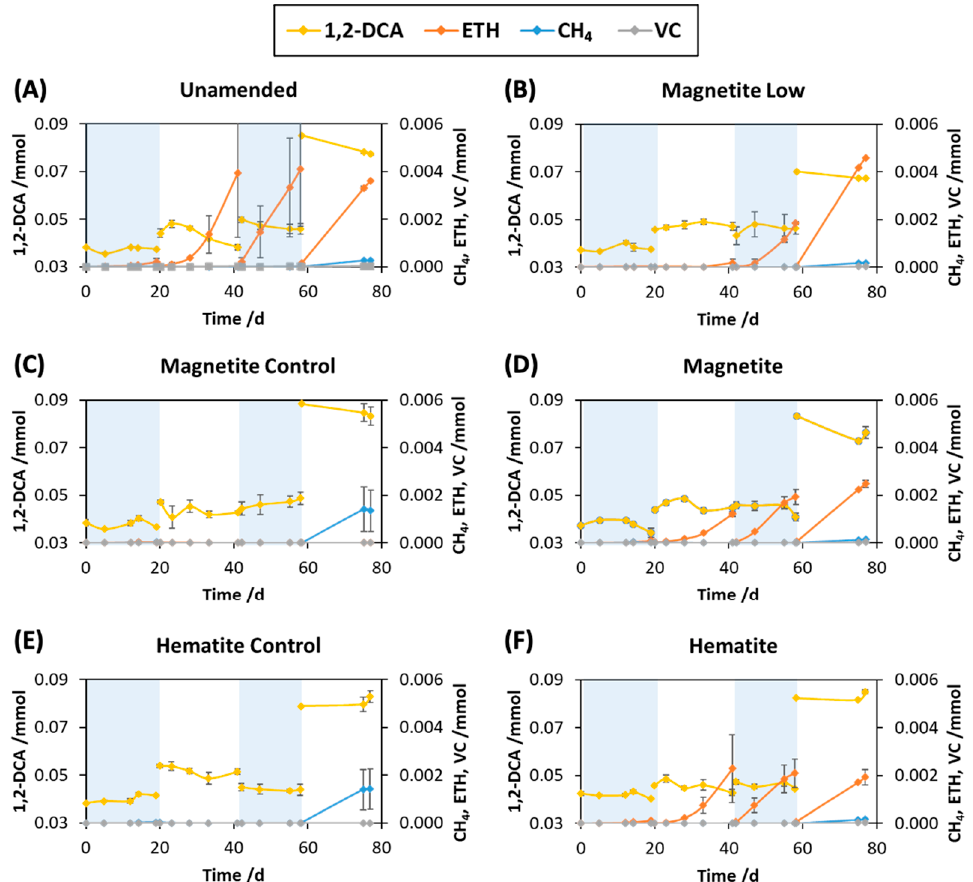
Figure 4. Trends of 1,2-DCA, ETH, VC and CH 4 for all treatments, namely: ( A ) Unamended control; ( B ) Magnetite low; ( C ) Non-inoculated Magnetite control; ( D ) Magnetite; ( E ) Non-inoculated Hematite control; ( F ) Hematite. The values are obtained as average of two replicates.